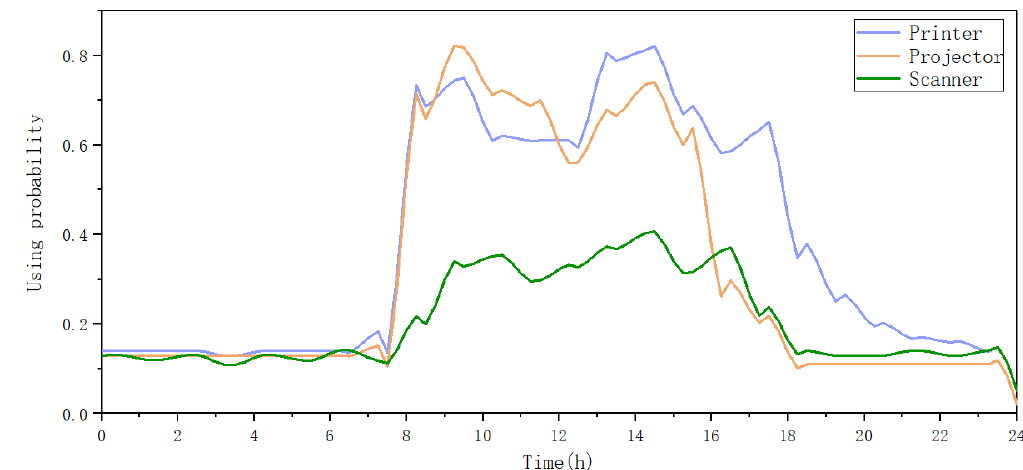
Figure 9. Probability of using different appliances at different times.